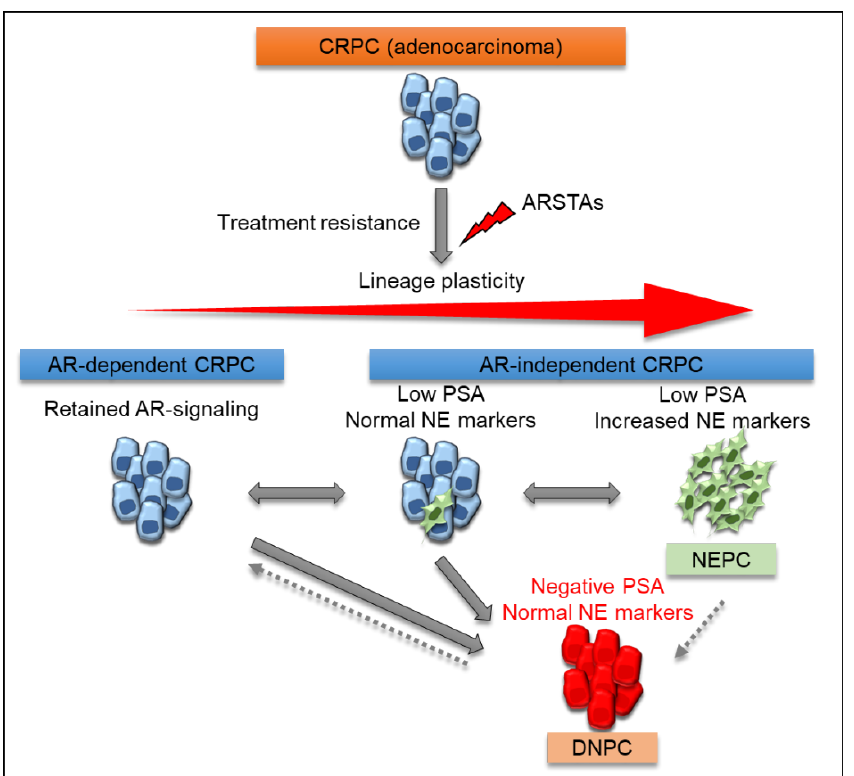
Figure 3. Schematic presentation of the representative transition states the underlying lineage plasticity that occurs during CRPC progression following strong suppression of AR signaling. The long-term use of potent ARSTAs and additional molecular modifications were suggested to may be eventually lead to lethal DNPC via the biological changes between AR-dependent CRPC and NEPC. AR androgen receptor, NE neuroendocrine, ARSTAs AR signaling-targeted agents, CRPC castration-resistant prostate cancer, NEPC neuroendocrine prostate cancer, DNPC double- negative CRPC.